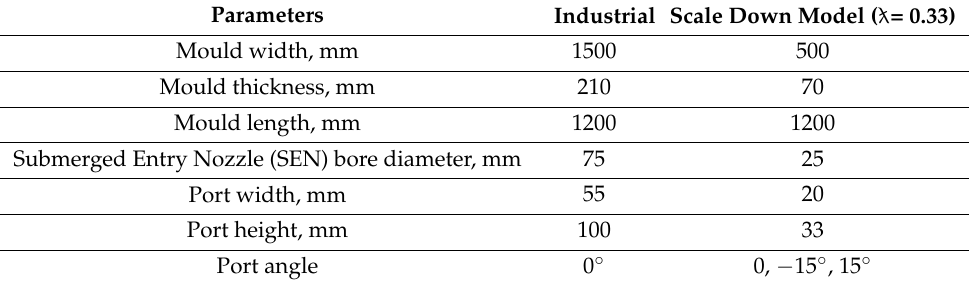
Table 2. Dimension of industrial and scaled-down models of slab